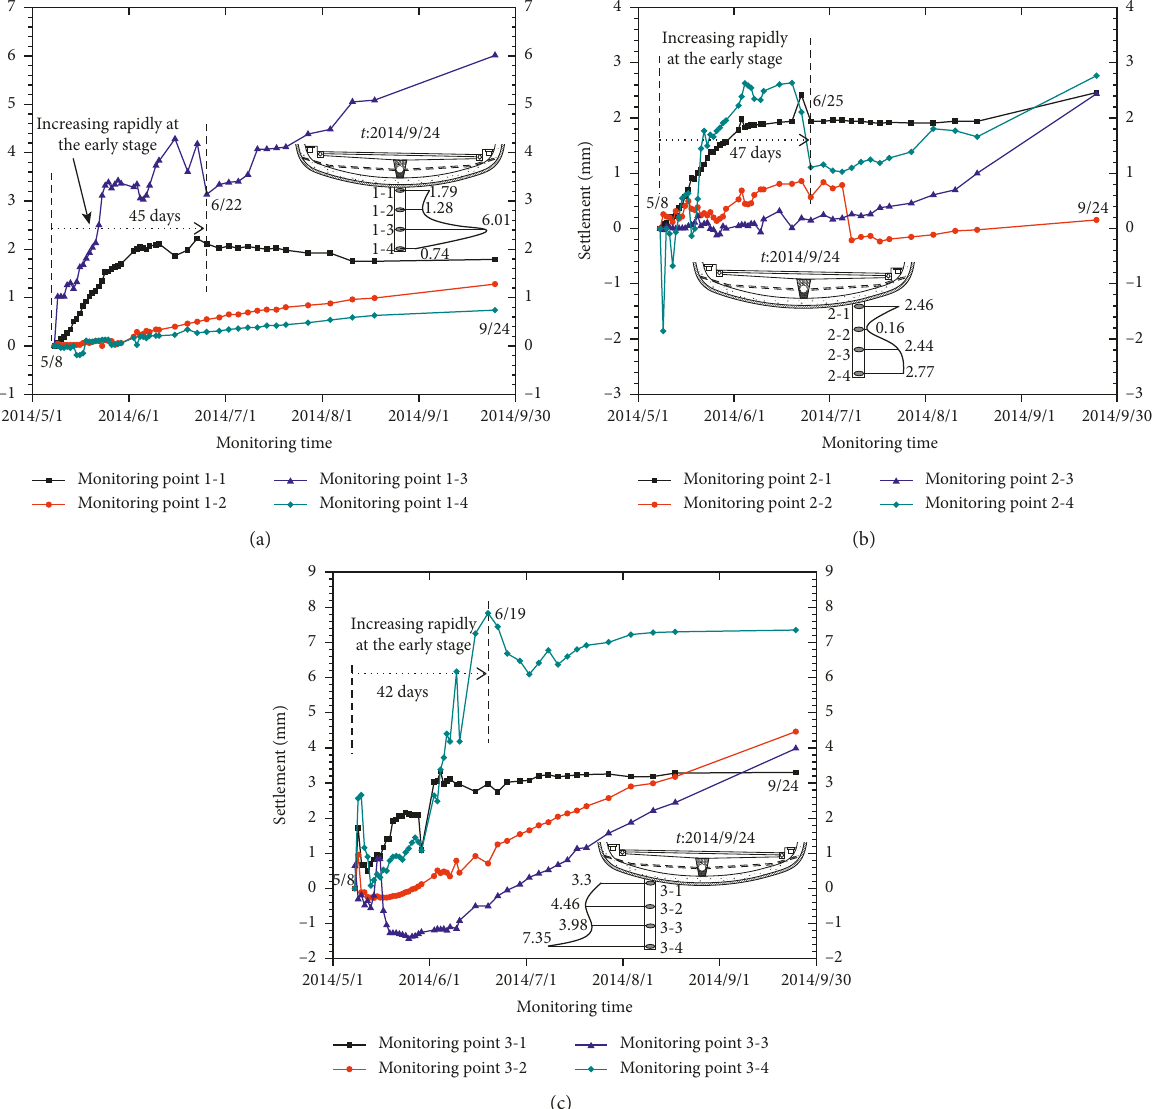
Figure 16: Variation of the settlement with time at the tunnel bottom. (a) Monitoring point 1. (b) Monitoring point 2. (c) Monitoring point 3.